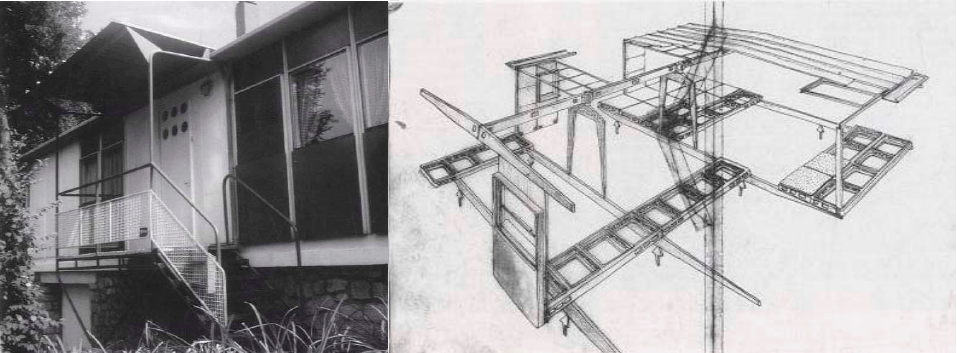
Figure 3. Meudon Houses by Jean Prouvé, Paris, 1949 [7].